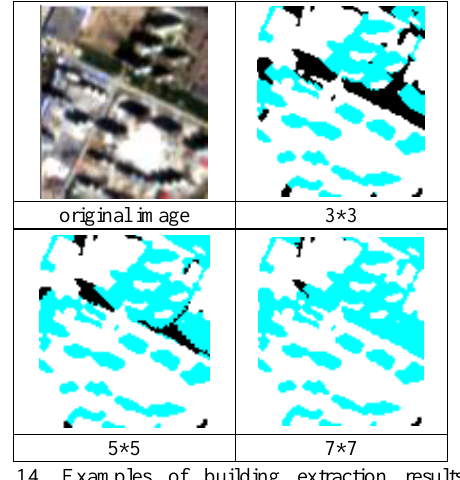
Figure 14. Examples of building extraction results with structure elements of different